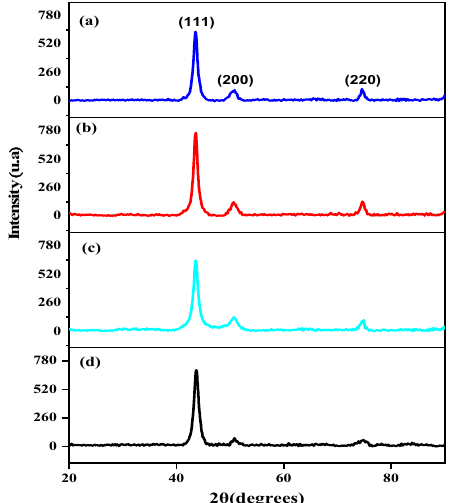
Figure 11. XRD patterns of Ni-W/SiC composite coatings on grit-blasted 45 steel obtained at different